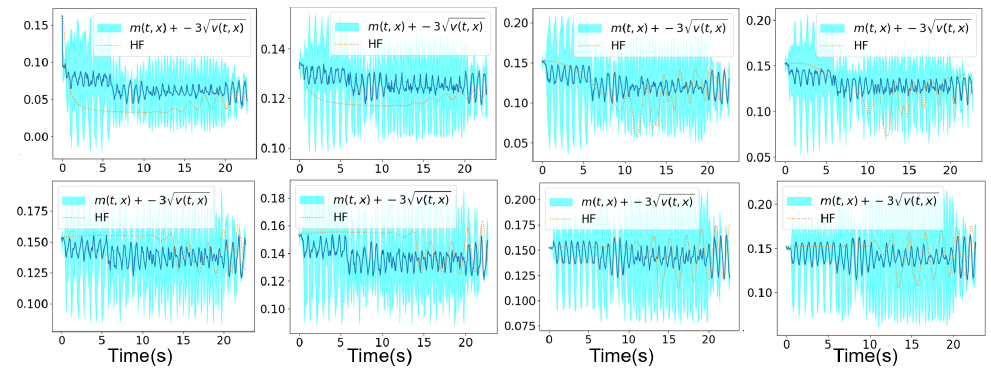
Figure 8. mesh n°1: High-fidelity Yales2 horizontal velocity projected on the Cartesian mesh in brown and the horizontal component of the mean prediction of the Bayesian ROM in dark blue, at